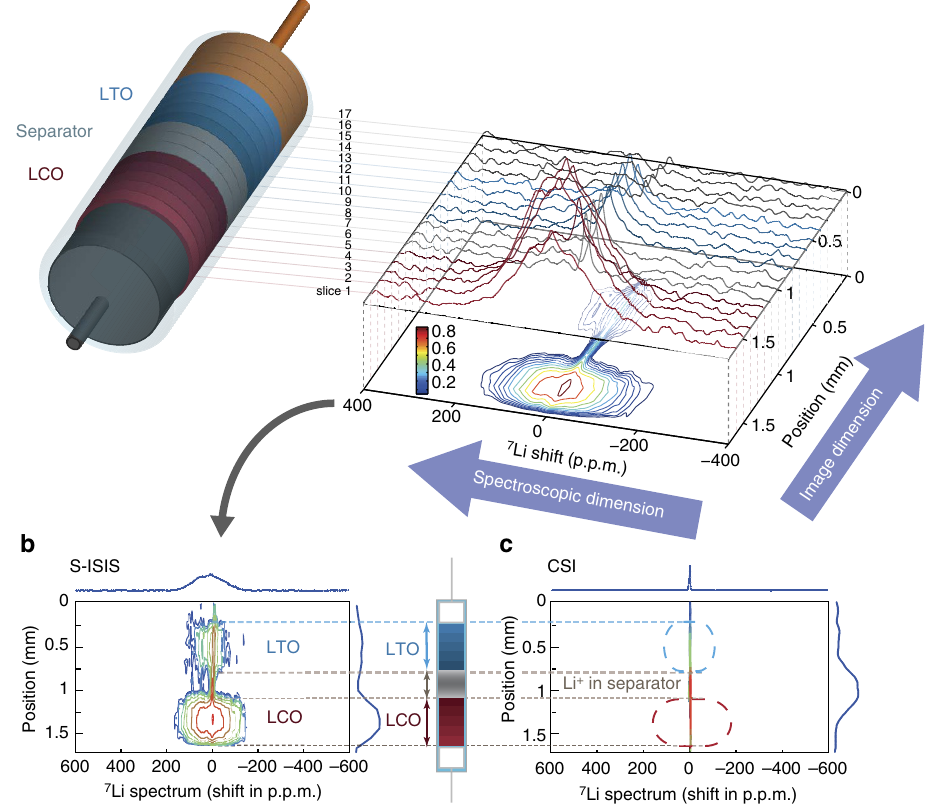
Figure 2 | 7 Li Scanning ISIS of the LCO/LTO battery. ( a ) Series of spectra obtained for horizontal slices of thickness 100 m m in the battery. Slices 1, 5 and 13 are less intense because they are astride the electrode and the electrolyte. The spectroscopic image is reconstructed from the series of spectra and correlates spectrum and position. The corresponding contour map is shown below. Signal intensity for each contour in the map is colour-coded as indicated by the colour bar. The electrolyte soaking the whole cell is evidenced in all slices by a sharper signal close to 0p.p.m., overlapping with the electrode spectrum. ( b , c ) Comparison of the NMR spectroscopic images for the LCO/LTO battery obtained with ( b ) the S-ISIS method (FOV 1.7mm, 17 slices, no slice gap) and ( c ) the standard CSI (FOV 2.5mm, only 1.7mm shown, that is, 27 slices). No signal is obtained for LTO and LCO in the CSI spectroscopic image, contrary to the S-ISIS image. Spectral width: 200kHz; acquisition time: 3h 20min for S-ISIS, 3h 38min for CSI; resolution: 100 m m for S-ISIS, 77 m m for